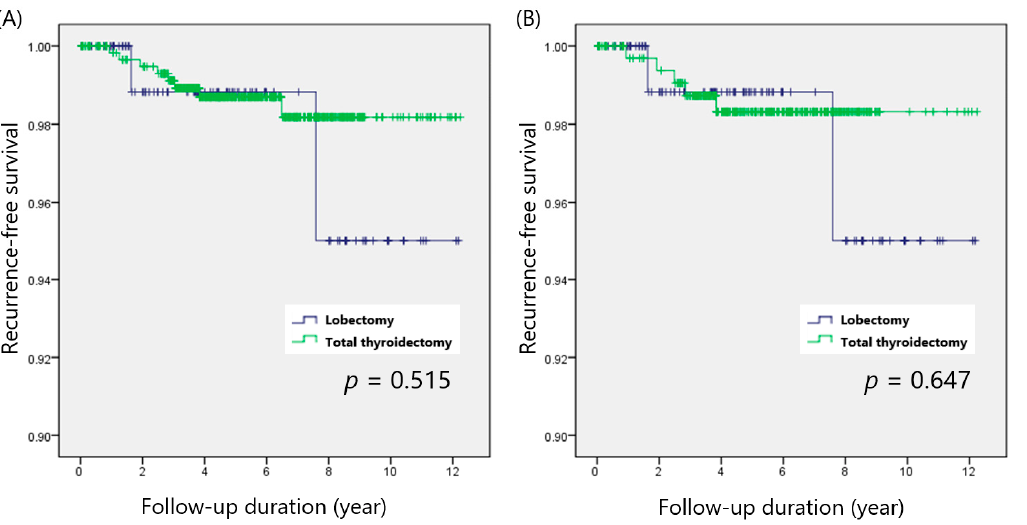
Figure 1. Recurrence-free survival according to the operative extent in patients with multifocal PTCs, ( A ) before and ( B ) after propensity score matching.